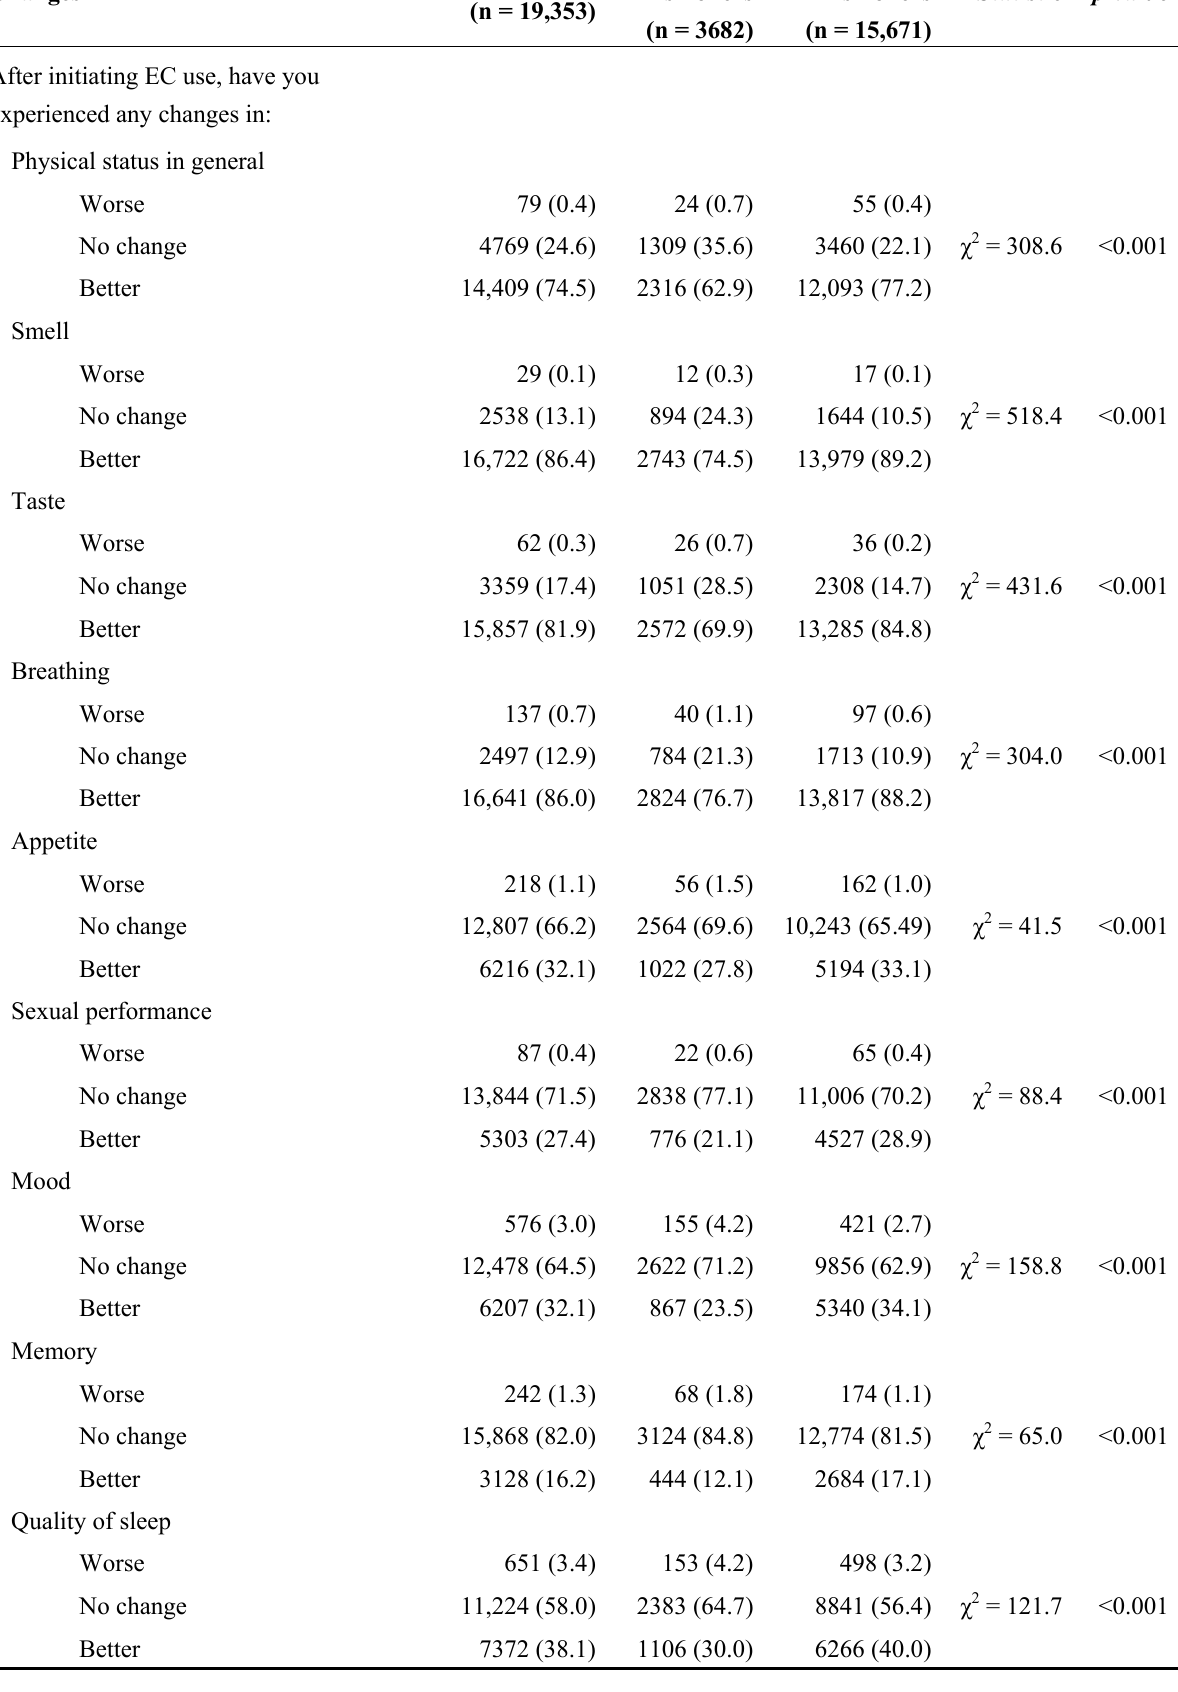
Table 5. Changes in physiologic functions after electronic cigarette use initiation.